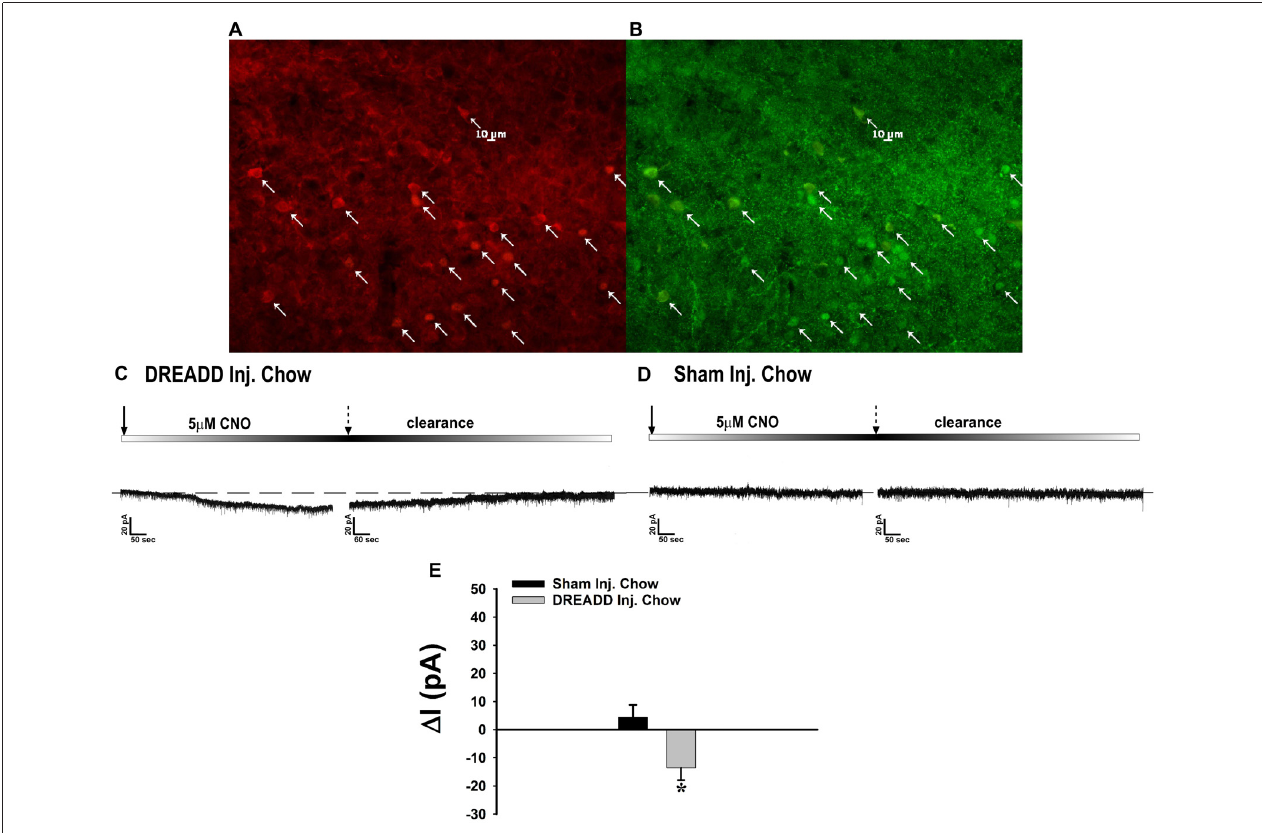
FIGURE 10 | Chemostimulation of VMN SF-1 neurons in male NR5A1-cre mice reversibly stimulates POMC neurons in designer receptor exclusively activated by designer drugs (DREADD)-injected but not sham-injected animals. The color photomicrograph shows the expression of the Gq-M3-DREADD (visualized with mCherry, A ) in SF-1 neurons (visualized with AF488, B ). (C) Representative traces of membrane current showing that clozapine-N-oxide (CNO) (5 µ M) induced a reversible inward current in identified POMC neurons from DREADD-injected animals ( n = 13) that was altogether absent in cells from sham-injected animals ( D ; n = 4). The composite bar graph in (E) further illustrates the stimulatory effect of CNO in POMC neurons from DREADD-injected animals but not sham-injected animals. Bars represent means and lines 1 SEM of the CNO-induced change in membrane current. ∗ P < 0.05; Student’s t